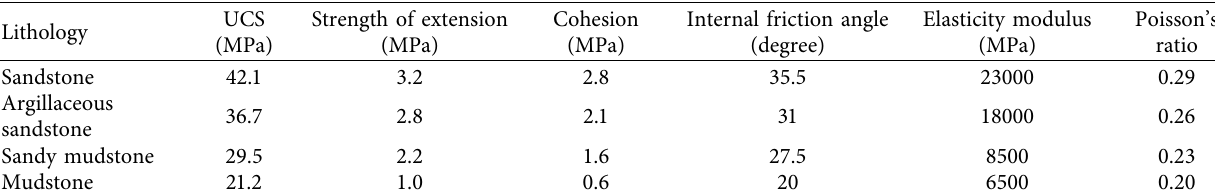
Figure 3: Deformation situations in 90mRL access. (a) Deformation and crack on the wall. (b) Roof break. (c) Floor heave. (d) Concrete layer falling Table 1: The physical and mechanical properties of rocks.